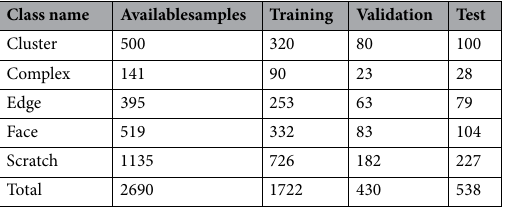
Table 1. Class distribution of the dataset (Train, Validation, and Test sets).